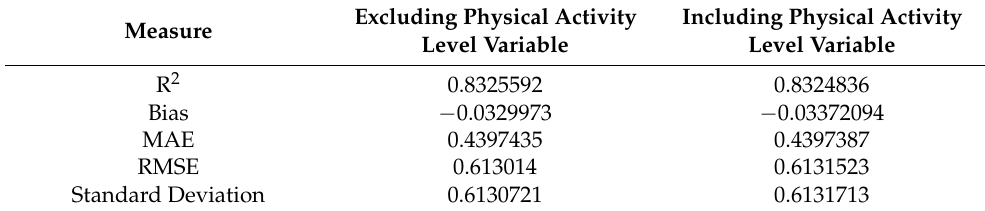
Table 5. Measures of adjustment and error of the models.